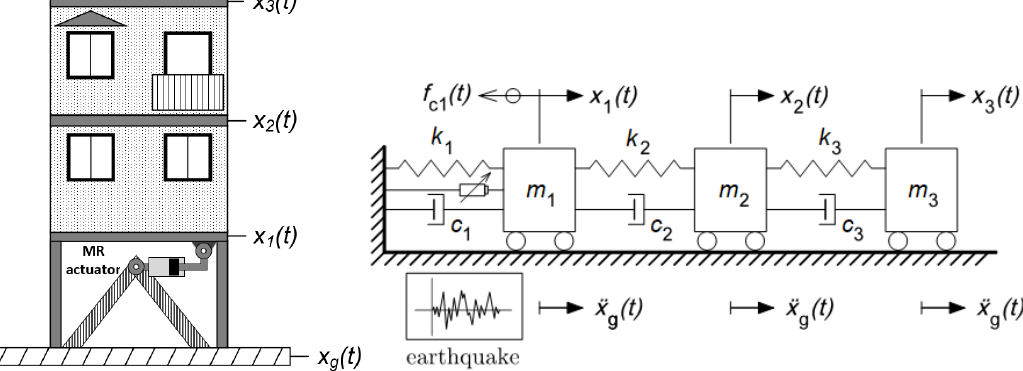
Figure 1. Building magneto–rheological (MR) actuator location ( left ) and lumped elements equivalent model ( right ).